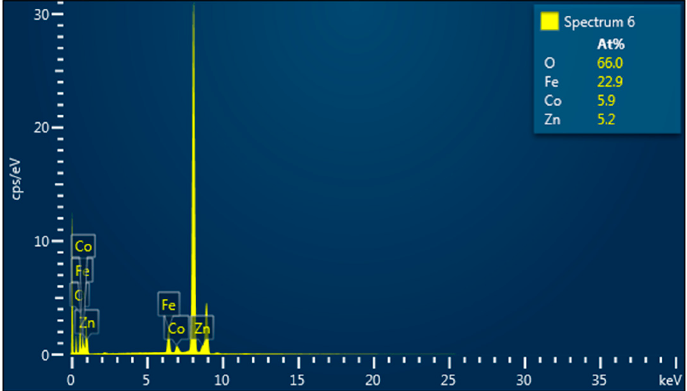
Figure 3. EDS spectra for Co 0.4 Zn 0.6 Fe 2 O 4 nanoparticles.